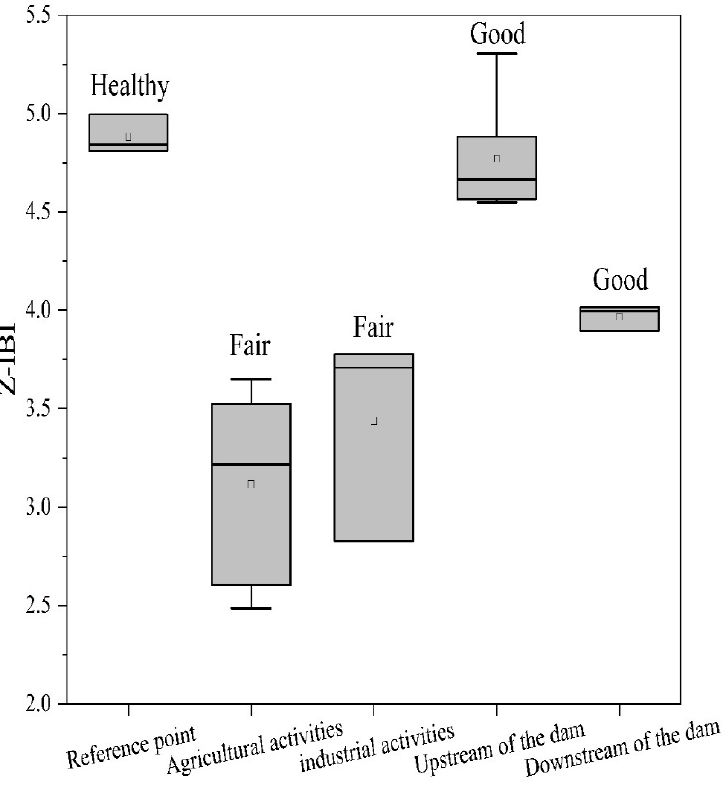
Figure 4. Zooplankton index of bio-integrity (Z-IBI) scores and health status in different areas of the Wanan River basin, China.